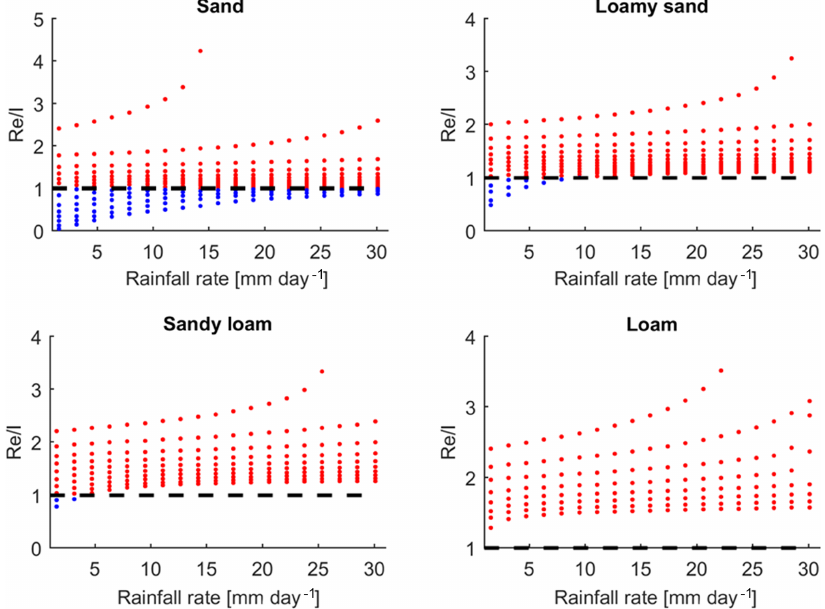
Figure 5. Variations of the ratio of recharge to infiltration with rainfall and initial depth to water table in different soil types simulated by ≥ 1, and the blue dots are Re < 1. MIKE SHE. The red dots are Re I I